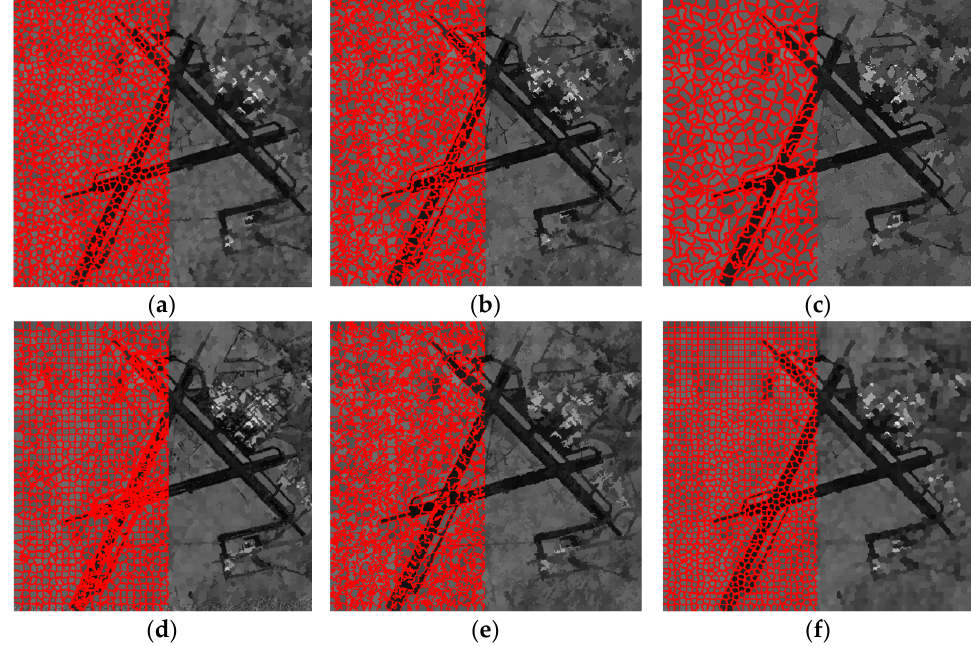
SI . ( a ) SLIC, ( b ) SNIC, ( c ) SEEDS, 4